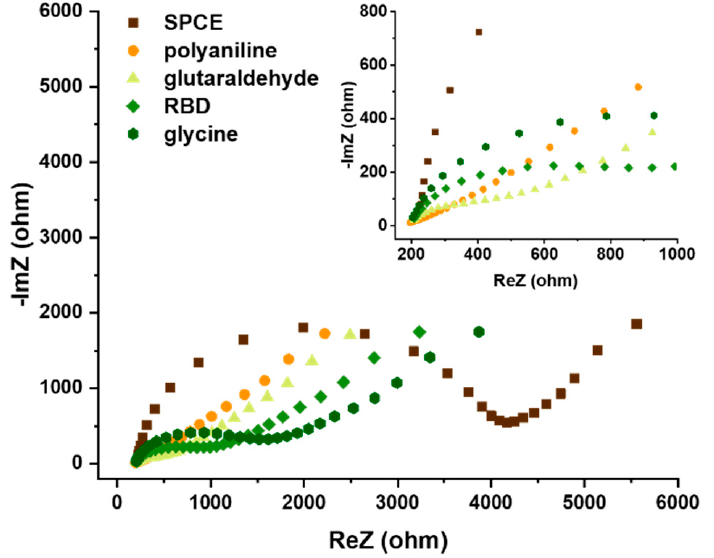
Figure 2. EIS (Nyquist plots) measurements for a stepwise preparation of the immunosensor